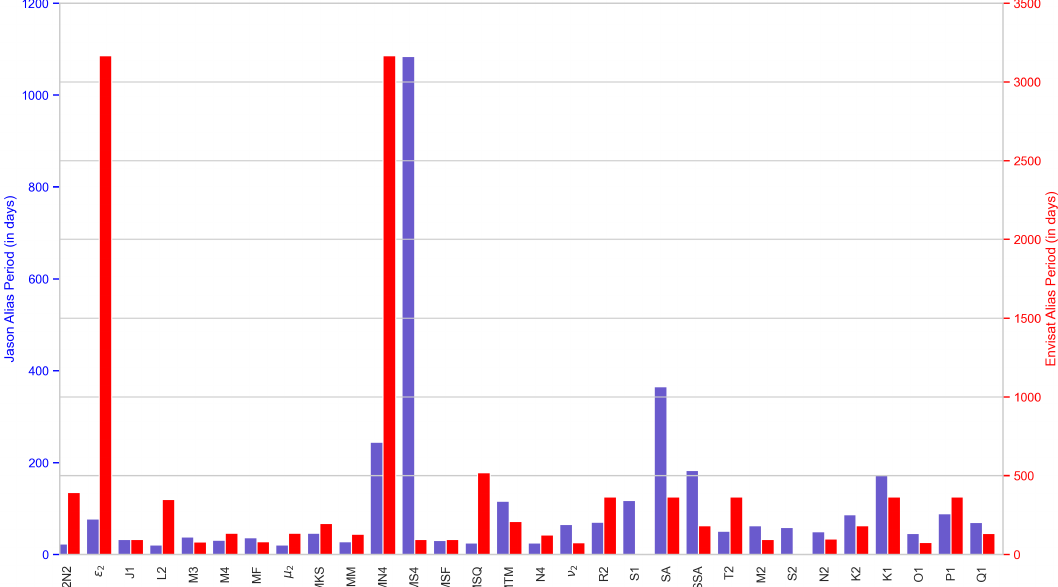
Figure 2. The alias period (in days) for all the tidal constituents available from FES2014, with the blue bars indicating the Jason orbit missions and the red bars representing Envisat orbit missions. The S1 and S2 tidal constituents of the Envisat orbit have an aliasing period of infinity due to their sun-synchronous